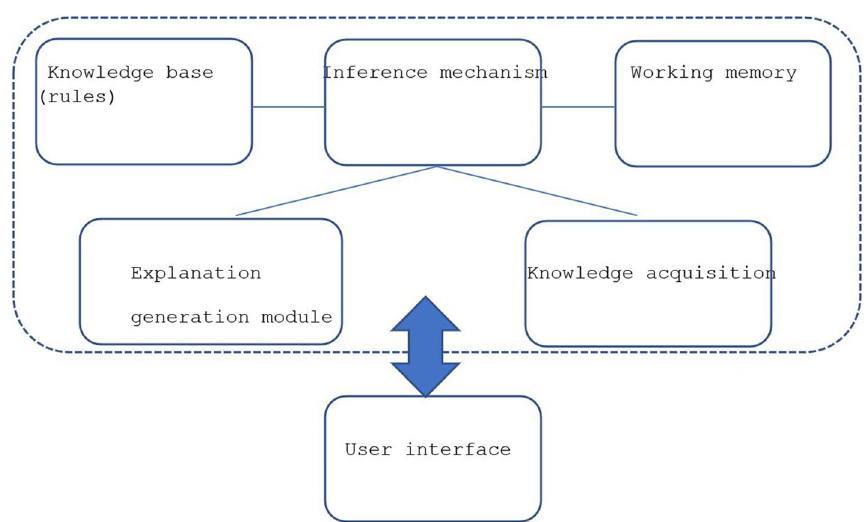
Fig. 3 Knowledge-based system (Source: Matelli